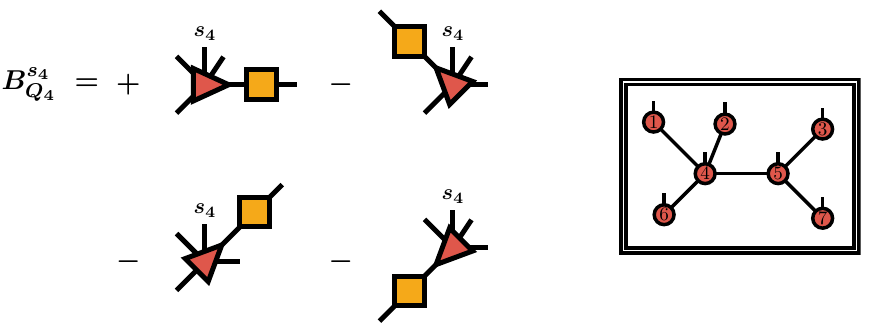
Figure 5: Definition of the vertical subspace for site 4 in Eq. 9 with end point site 7. The space of all tensors defining the kernel of the map from the tangent space to the physical hilbert space, is spanned by a matrix X (yellow squares) for each link of q (cid:48) q l l the TTN. The physical index s is labeled separately to distinguish it from the bond 4 indices. The inset is a reminder of the TTN used in this